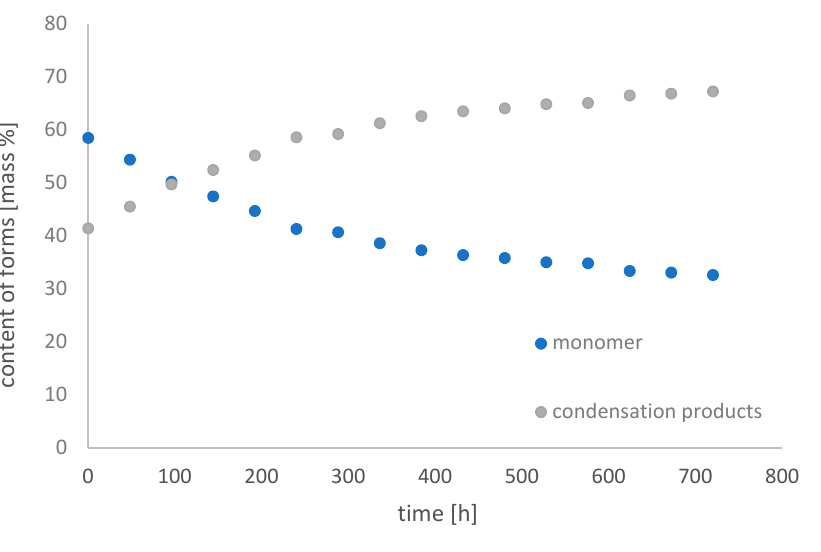
Figure 12. Change in the content of iron(III) ethylenediamine- N,N ′ -di[(2-hydroxy-5- sulfophenyl)acetic acid] forms with time in an aqueous solution at pH 5.